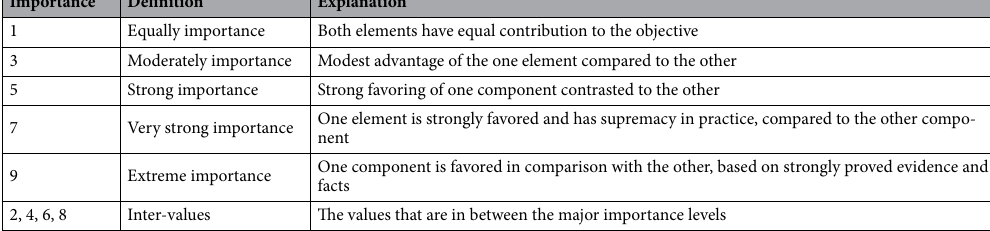
Table 1. Importance scale of analytic hierarchy process (AHP) 29,30 .